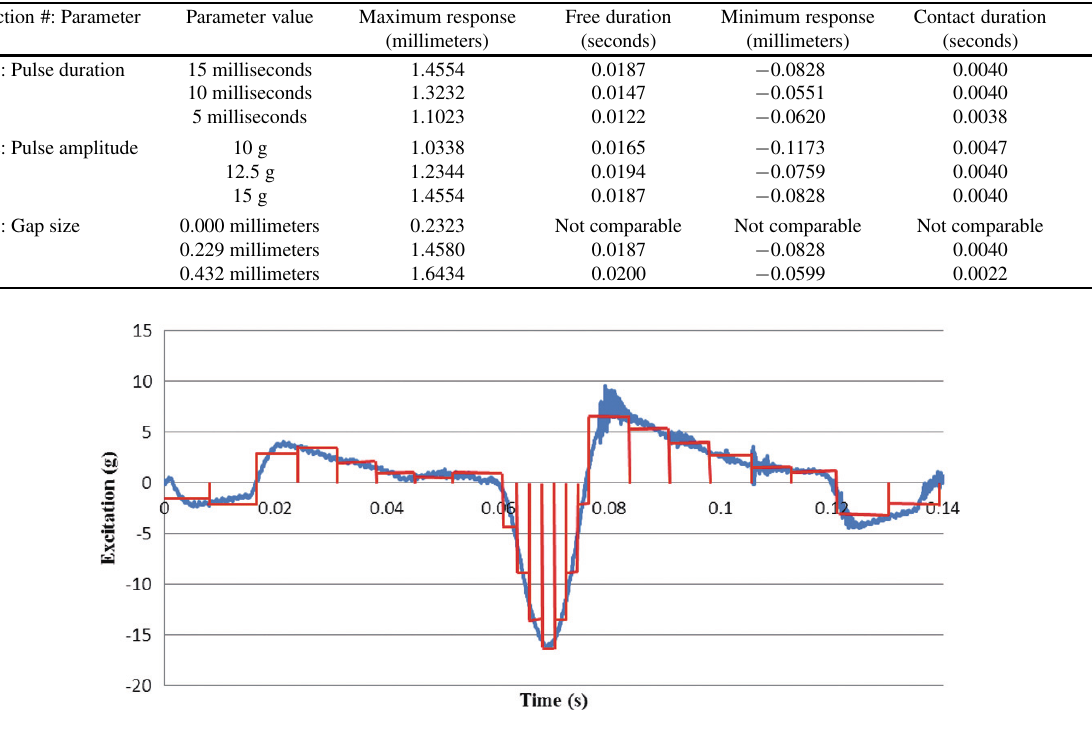
Fig. 3. Discretization of experimental excitation for